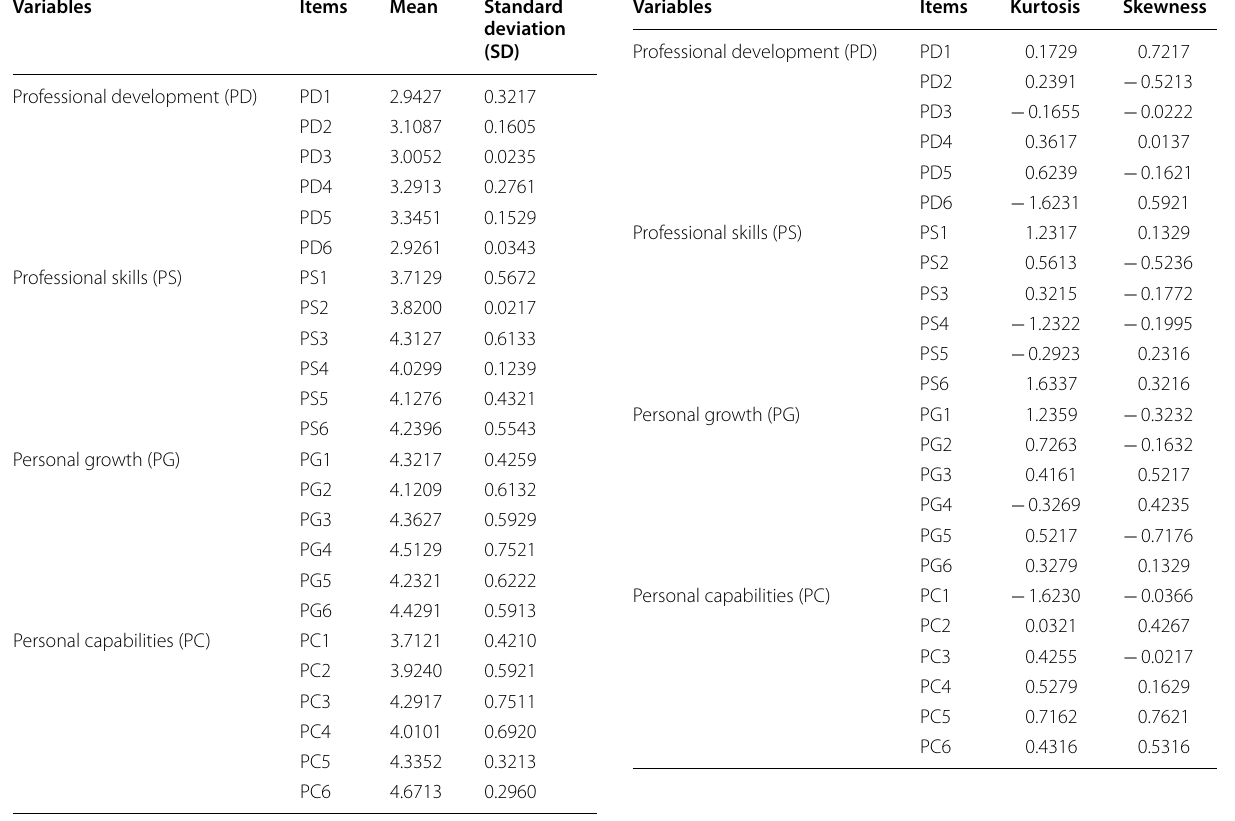
Table 3 Measurement of central tendencies Source : developed for the study Variables